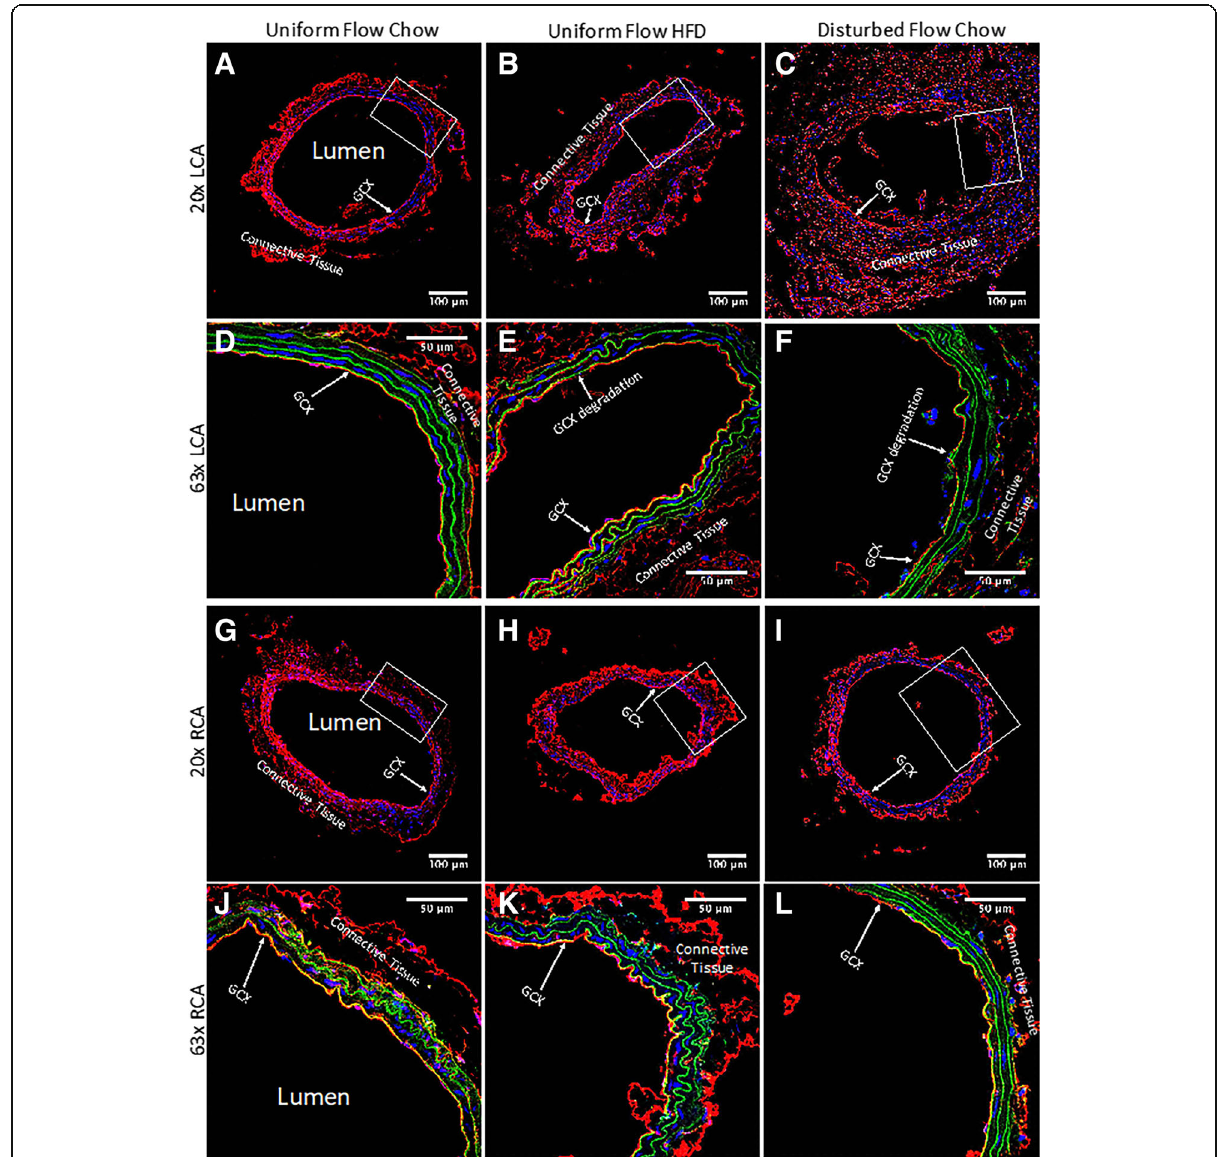
Fig. 4 GCX in carotid artery rings of different mice cohorts was stained with WGA tagged with red fluorescence. Blue signifies DAPI labeled cell nuclei and green signifies elastin autofluorescence. These confocal images are representatives of arterial rings in the cohorts. a 20x image of the LCA obtained from an ApoE-KO mouse with a regular chow diet and exposed to uniform blood flow patterns. b 20x image of the LCA from an ApoE-KO mouse fed a HFD and exposed to uniform flow. c 20x image of the LCA from an ApoE-KO mouse on a regular chow diet and exposed to disturbed blood flow due to partial ligation. d 63x image of ( a ) zoomed in on the boxed area, showing a continuous GCX layer. e 63x image of ( b ) zoomed in on the boxed area, showing a discontinuous GCX layer. f 63x image of ( c ) zoomed in on the boxed area also, also showing a compromised GCX layer. g 20x image of the RCA obtained from an ApoE-KO mouse with a regular chow diet. This RCA was exposed to uniform blood flow while its corresponding LCA was also exposed to uniform blood flow. h 20x image of the RCA from an ApoE-KO mouse on a HFD. This RCA was exposed to uniform blood flow while its corresponding LCA was also exposed to uniform blood flow. Finally, i 20x image of the RCA from an ApoE-KO mouse on a regular chow diet. This RCA was exposed to uniform blood flow while its corresponding LCA was exposed to disturbed blood flow. j 63x image of ( g ) zoomed in on the boxed area, demonstrating a continuous GCX layer. k 63x image of ( h ) zoomed in on the boxed area, showing a continuous GCX layer. l 63x image of ( i ) in the designated boxed area also, showing a continuous GCX